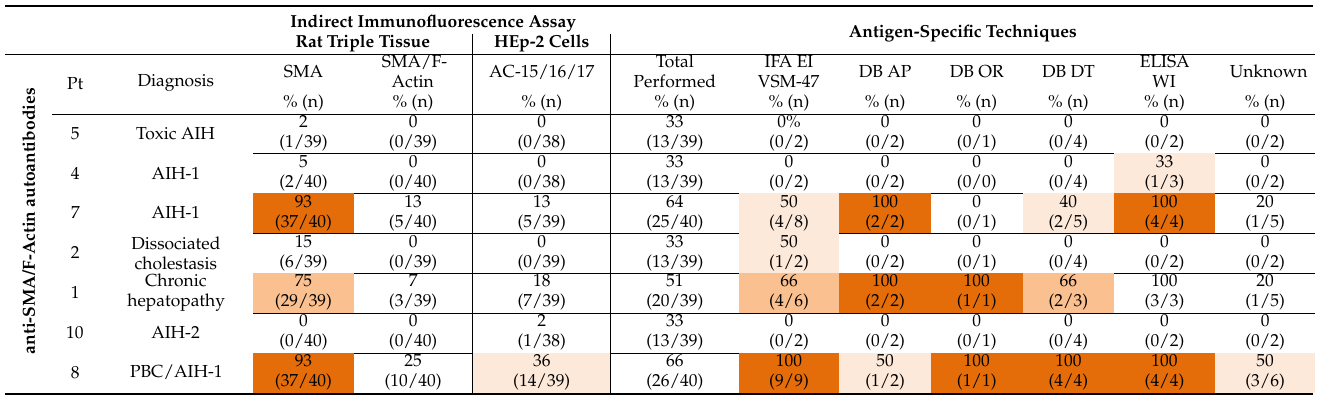
Table 2. Description of anti-SMA/F-actin autoantibodies results in AIH patients. Indirect Immunofluorescence Assay Antigen-Specific Techniques Rat Triple Tissue HEp-2